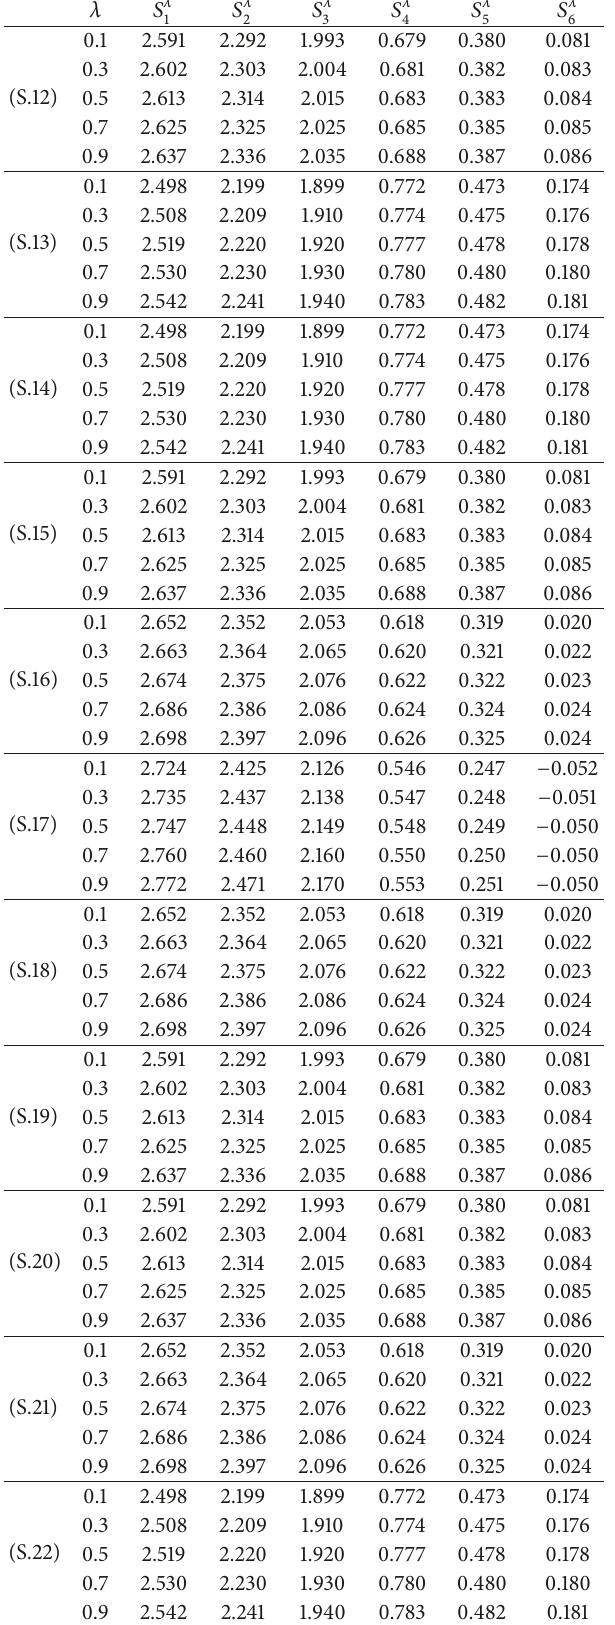
Table 4: Critical values to evaluate fuzzy 𝑠